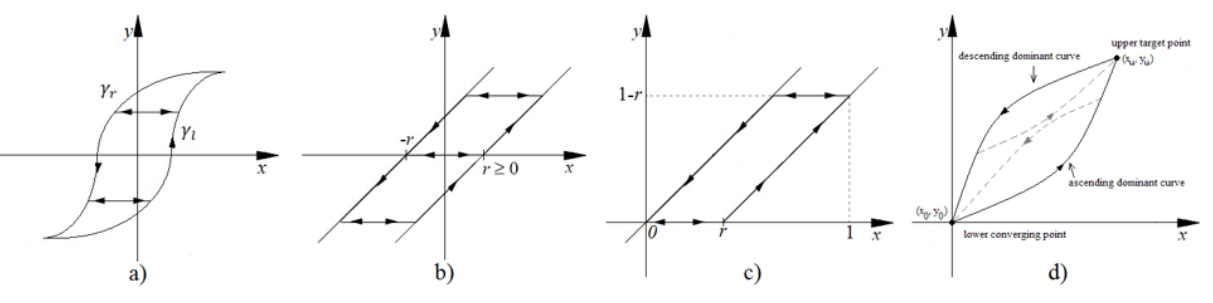
Figure 5. ( a ) Generalized play operator; ( b ) Classical play operator; ( c ) OSP operator; ( d ) Dominant